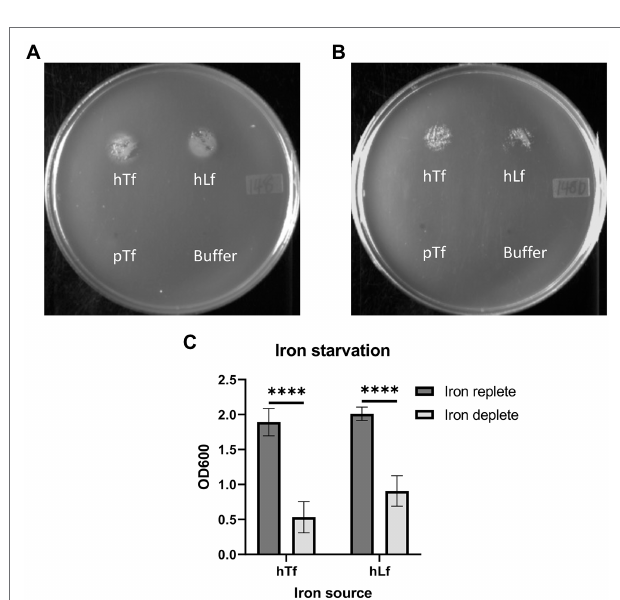
FIGURE 3 | Effect of iron starvation on the growth phenotype of the wild type strain on Tf and Lf as the sole iron source. Moraxella catarrhalis wild type (N148) that was either grown in iron-replete (Panel A ) or iron-depleted (Panel B ) conditions was plated onto BHI agar with 50 ug/ml of Desferal. A 5 μ l solution alone or containing 3.1 nmole of hTf, hLf or porcine Tf (pTf) was spotted onto the plate and incubated overnight for growth. OD600 quantification of bacterial growth from the plate assay (Panel C ). Results are presented as mean ± SEM. Each bar represents five replicates. ****Denotes p <